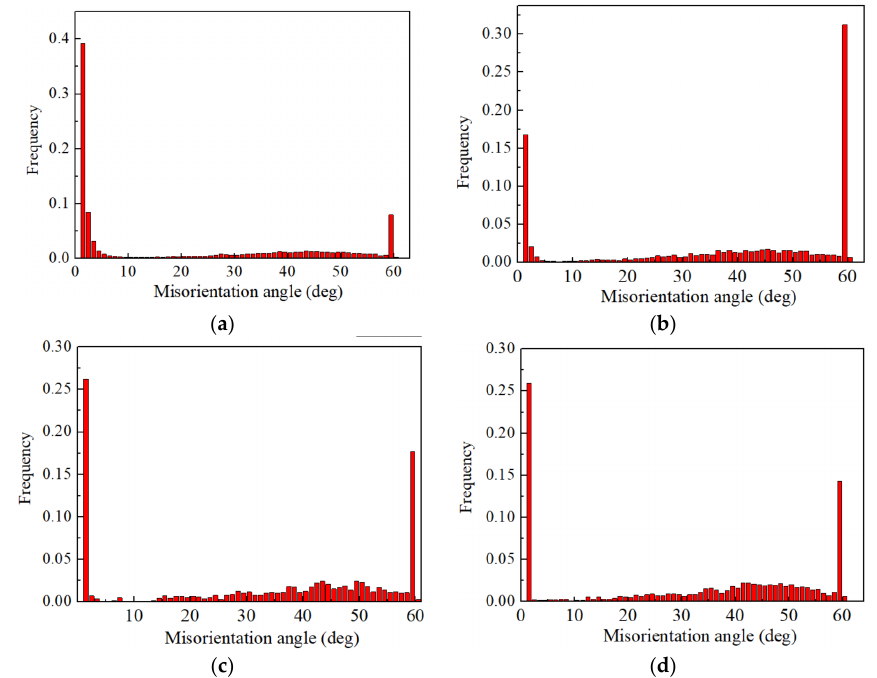
Figure 9. The misorientation distribution maps of 2W deformed at 1000–1150 ◦ C with a strain rate of 1 s − 1 ; ( a ) 1000 ◦ C; ( b ) 1050 ◦ C; ( c ) 1100 ◦ C; ( d ) 1150 ◦